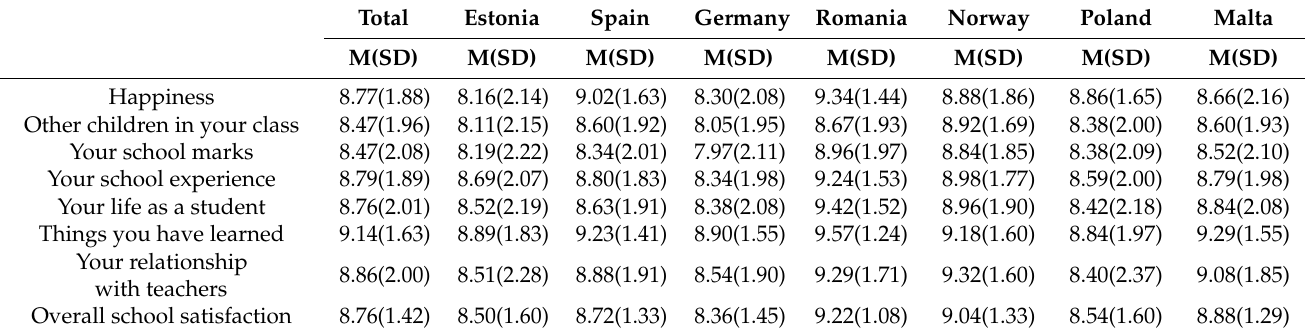
Table 3. Descriptive statistics of happiness and school satisfaction in the total sample and by country.